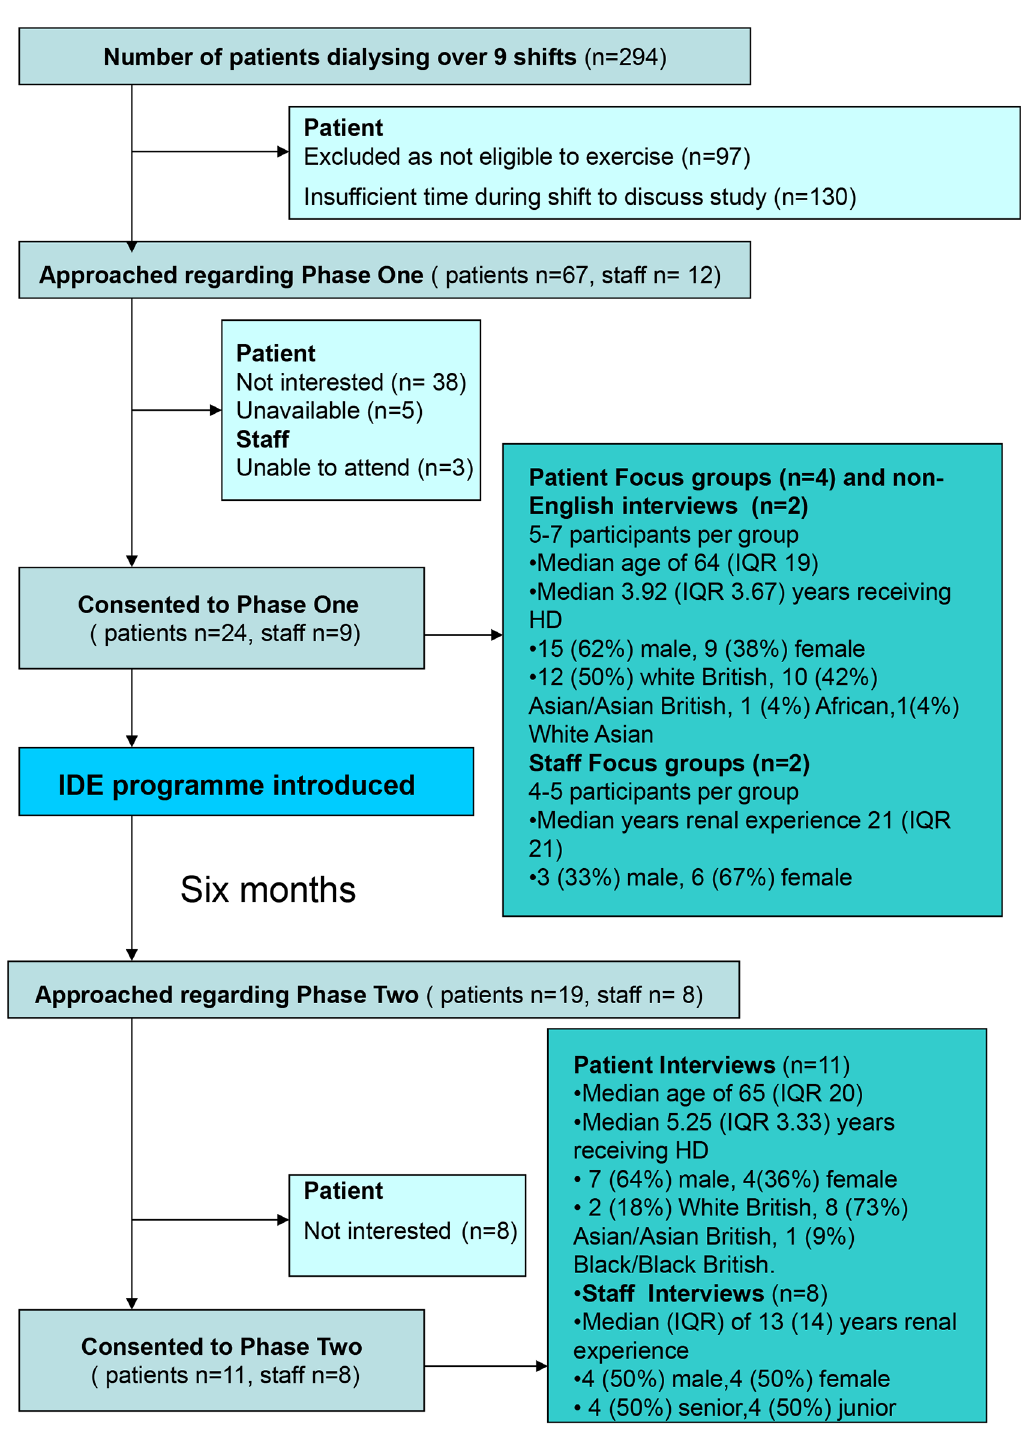
Fig 4. Consort diagram. Flow diagram illustrating participant characteristics and numbers of patients recruited at each phase of the study.